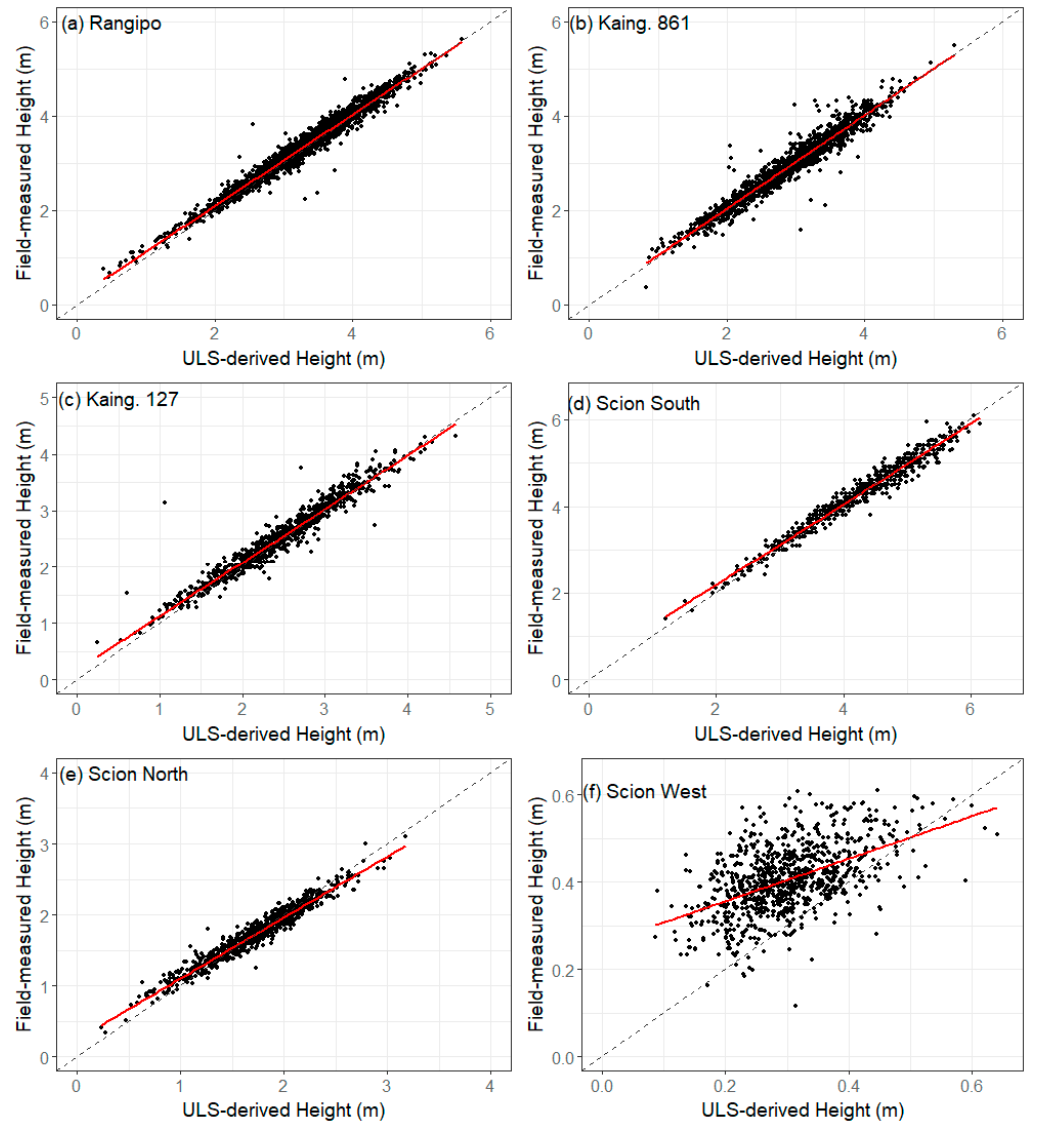
Figure 5. The relationship between field-measured and ULS-derived tree heights for ( a ) Rangipo, ( b ) Kaingaroa 861, ( c ) Kaingaroa 127, ( d ) Scion, South, ( e ) Scion, North and ( f ) Scion, West. Note the different y-axis scales between panels. The 1:1 line is shown as a dashed black line and a linear model fitted through the data is shown as a solid red line.